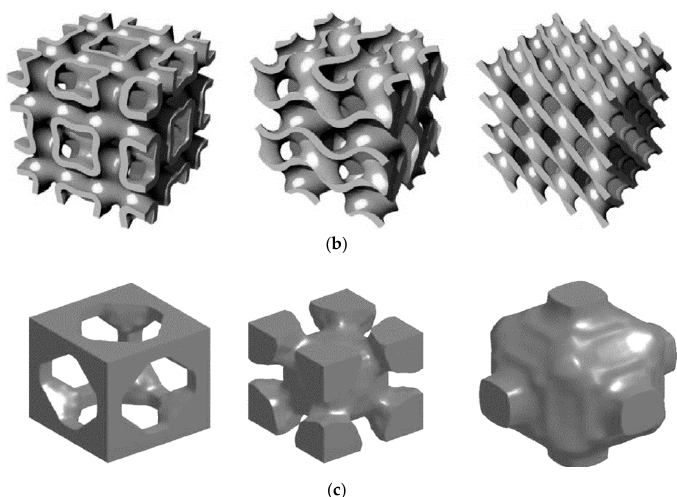
Figure 1. Different unit cell designs of lattice structures used in biomedical implants. ( a ) CAD-based unit cells [37]; ( b ) Implicit surface based unit cells [34]; ( c ) Topology optimized unit cells [38].